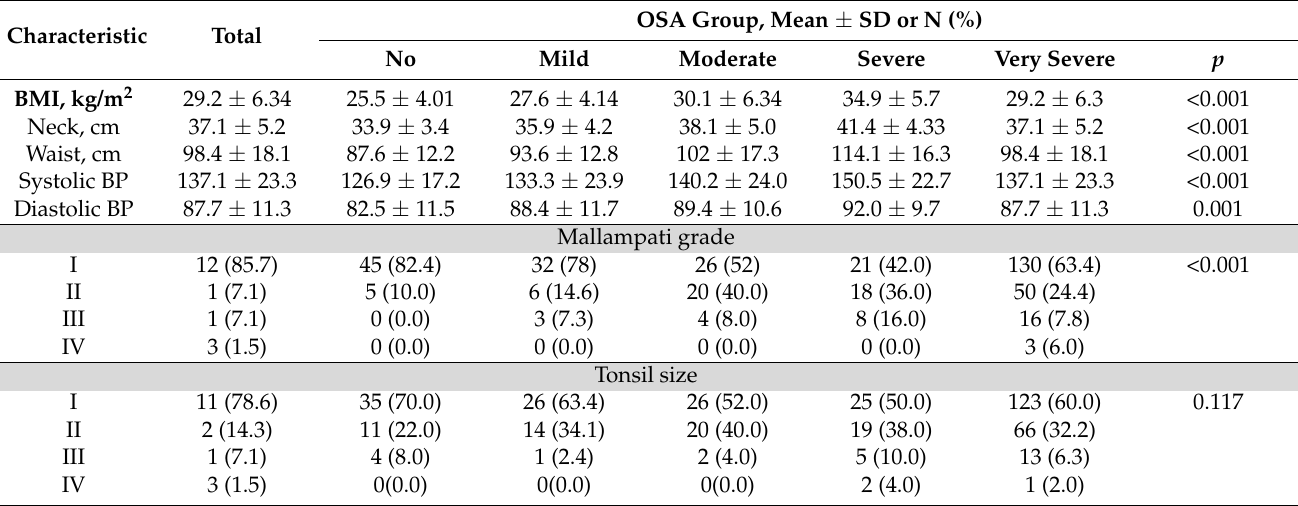
Table 2. Clinical characteristics of the patient sample and across OSA severity